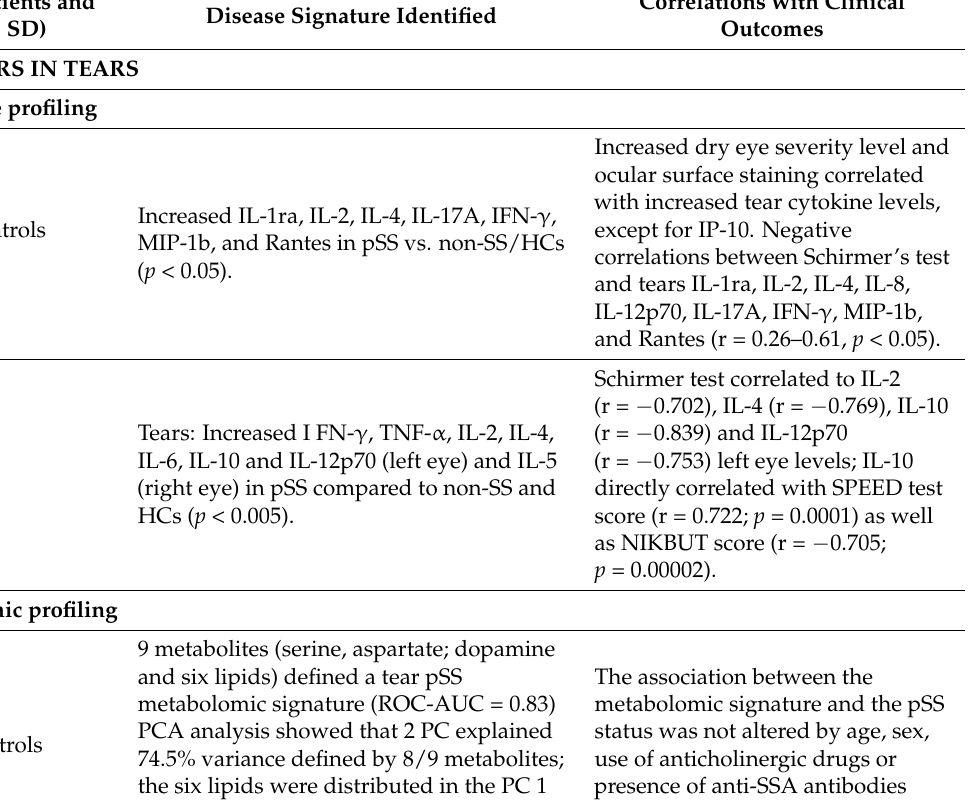
Table 1. Examples of studies investigating potential Sjögren’s Syndrome biomarkers in